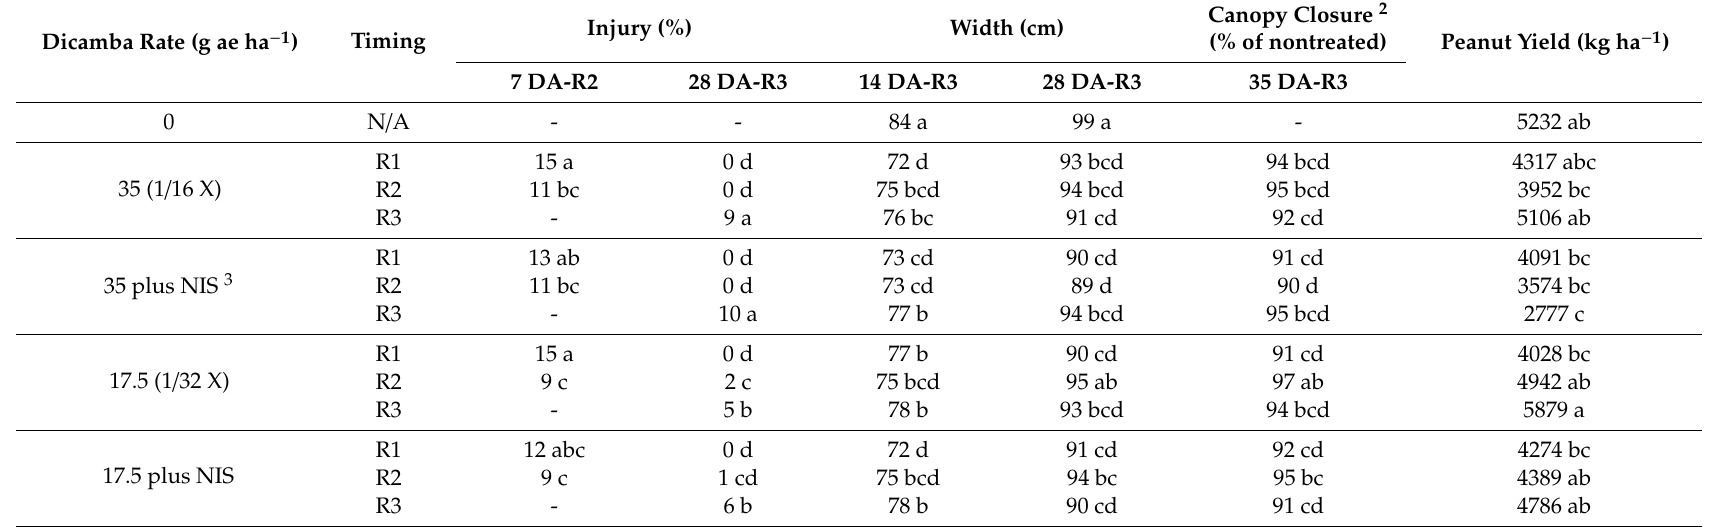
Table 1. Peanut injury, width, canopy closure, and yield following exposure to dicamba 7 DA-R2 1 and 28 DA-R3 at Stoneville, MS in